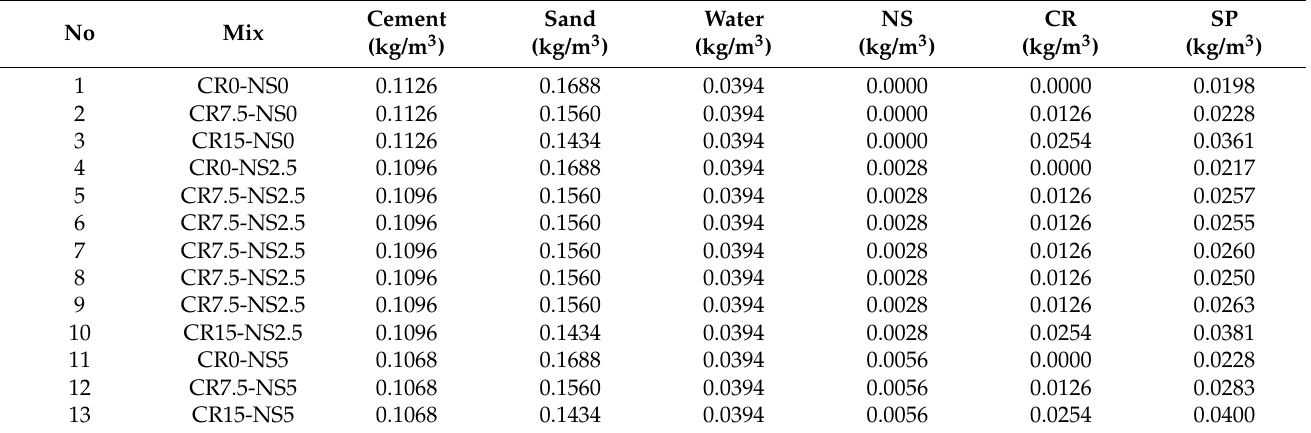
Table 5. Constituent materials for mortar